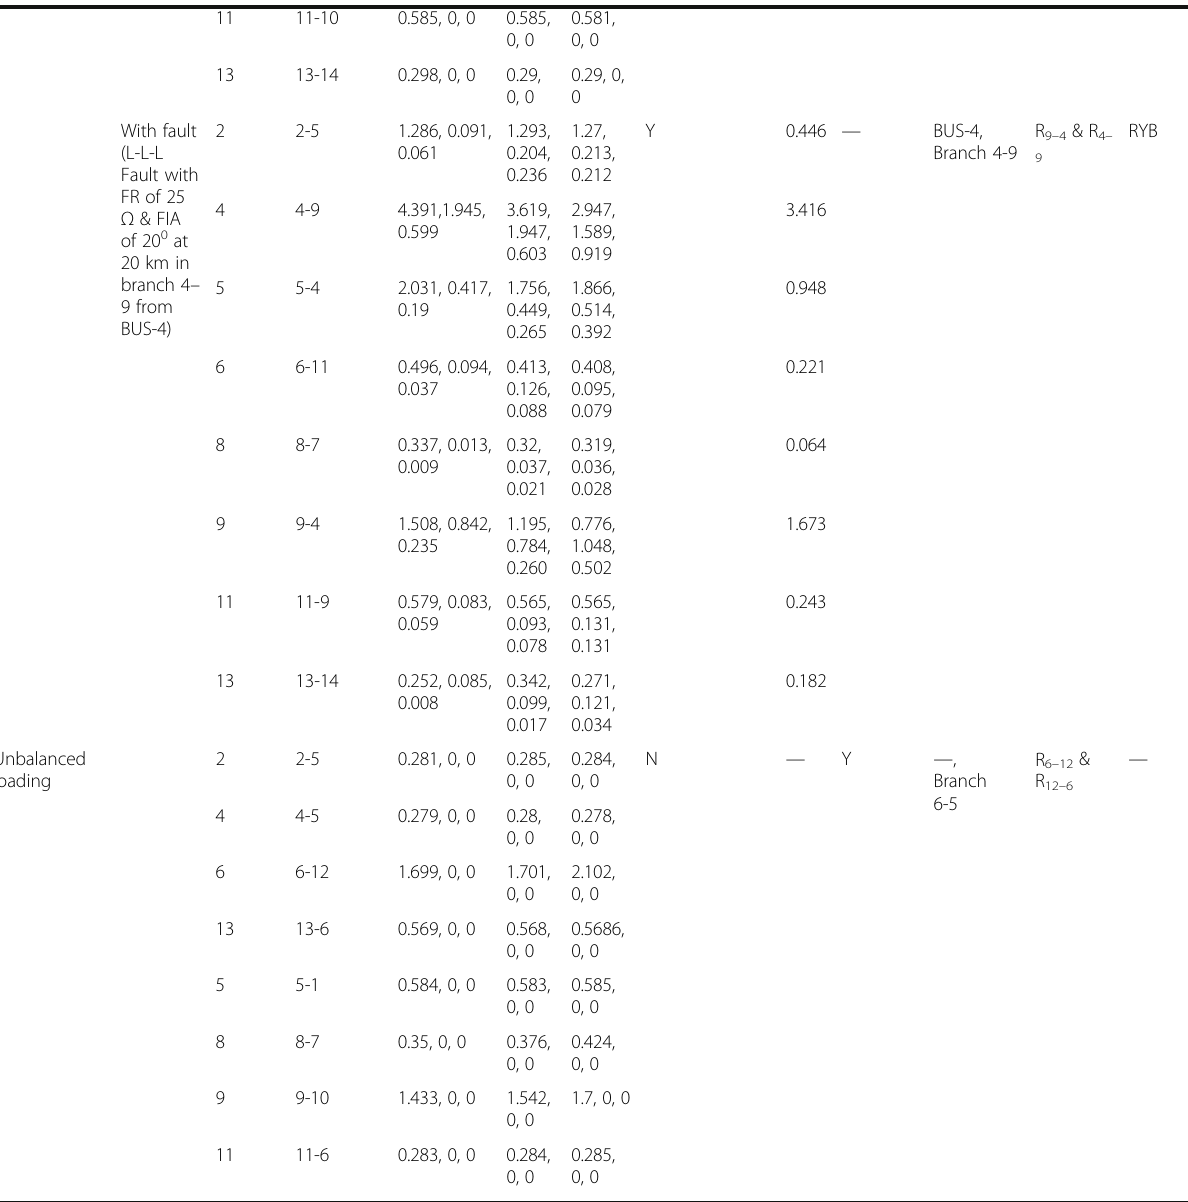
Table 4 Results of case studies conducted in IEEE-14 bus system under various power system conditions